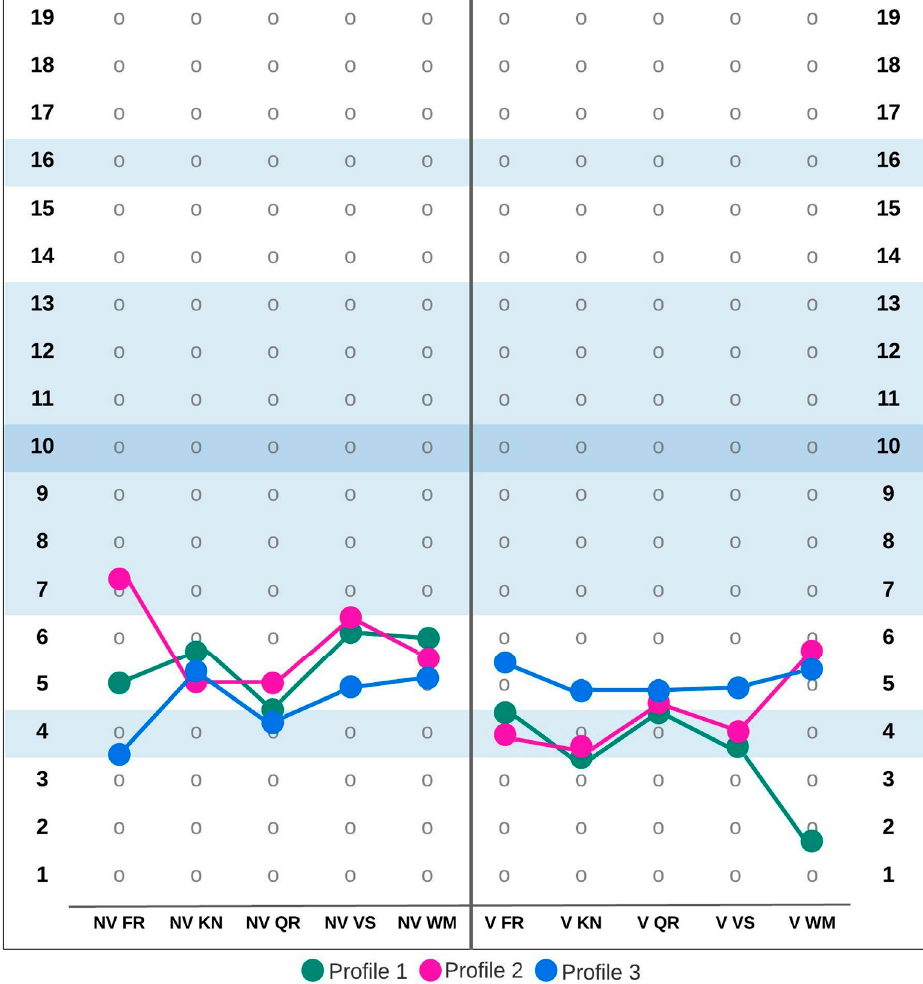
Figure 2. Mild intellectual disability cognitive profiles in the 10;00–14;11 age group. Abbreviations: NV FR—Nonverbal Fluid Reasoning, NV KN—Nonverbal Knowledge, NV QR—Nonverbal Quan- titative Reasoning, NV VS—Nonverbal Visual-Spatial Processing, NV WM—Nonverbal Working Memory, V FR—Verbal Fluid Reasoning, V KN—Verbal Knowledge, V QR—Verbal Quantitative Reasoning, V VS—Verbal Visual-Spatial Processing, V WM—Verbal Working Memory.